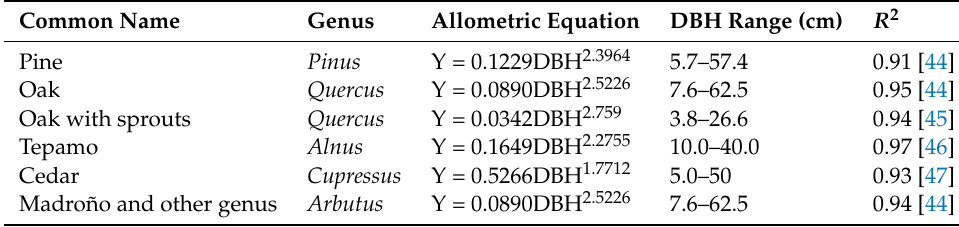
Figure 1. The location of the study area and the sampling sites. Table 1. The applied allometric equations for the calculation of the aboveground biomass